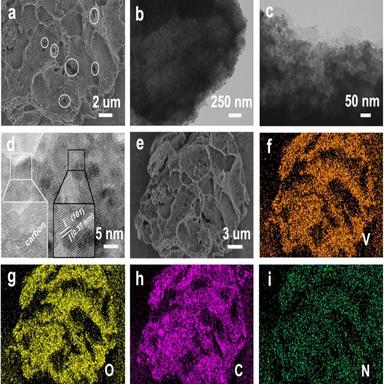
(a) SEM, (b, c) TEM, (d) HRTEM images and (e–i) element maps of LVO-m/c.